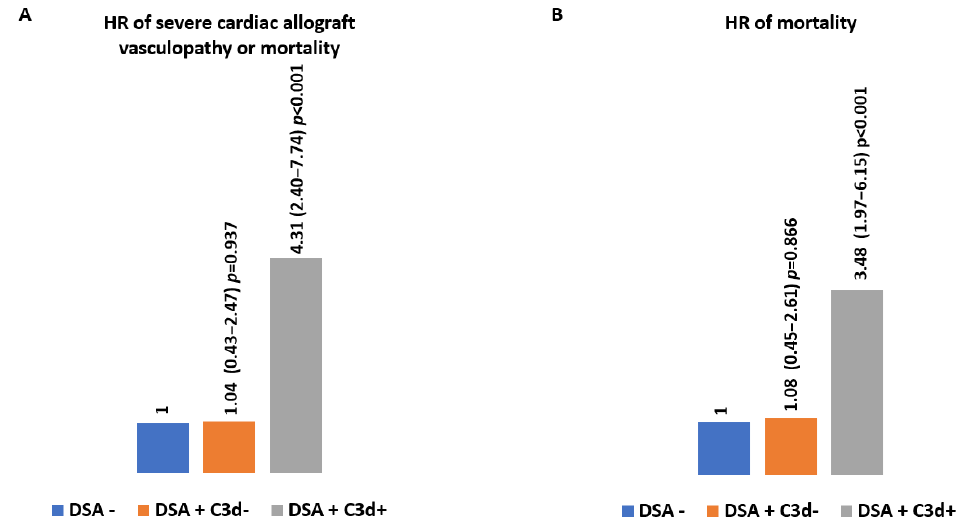
Figure 2. Association between outcomes and DSA and C3d status. Hazard ratio using time dependent Cox regression multivariate model with recipient sex, recipient age, total number of mismatches, number of rejection episodes ≥ grade 2, CMV mismatch, creatinine, and ejection fraction at time of coronary angiography. ( A ) severe cardiac allograft vasculopathy or mortality; ( B ) mortality.